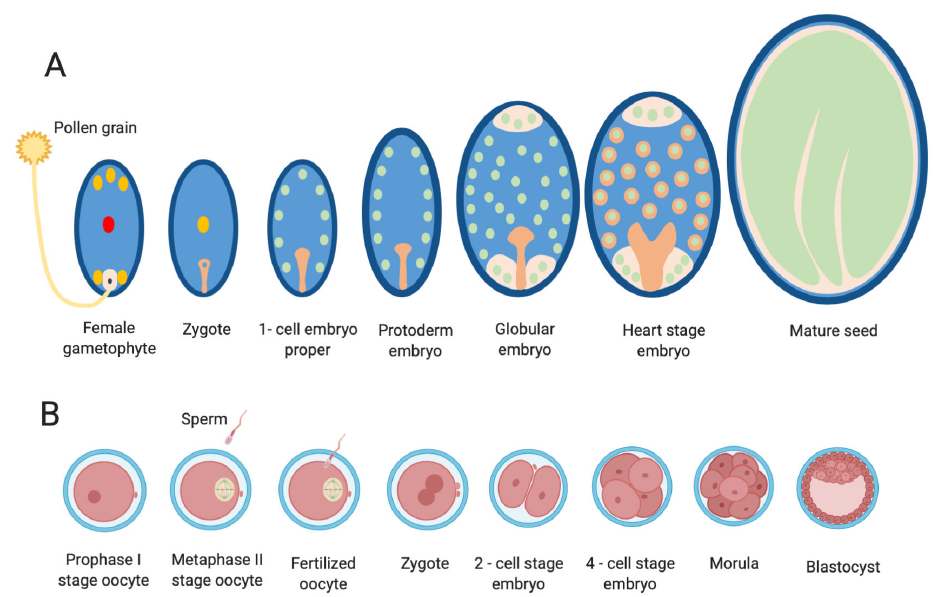
Figure 3. Schematic representation of fertilization and embryonic development in flowering plants ( A ) and mammals ( B ). Created with BioRender.com (https://biorender.com/, accessed on 28 January 2021). ( A ) In angiosperms, once the pollen grain attaches on the tip of the pistil, the pollen tube grows through the pistil and reaches the ovule located in the ovary. Upon fertilization, the ovule transforms into a seed. The ovule contains the female gametophyte, which consists of different specific cell types: 1 egg cell, 1 central cell, 2 synergid cells, and 3 antipodal cells. The two synergid cells attract the pollen tube in the direction of the ovule. When the pollen tube reaches the interior of the female gametophyte (embryo sac), the pollen tube delivers the two sperm cells inside the ovule. One of the sperm cells fuses with the egg cell, forming a diploid embryo, while the other sperm cell fuses with the nuclei of the central cell, forming a triploid endosperm. Once the zygote has been constituted, it undergoes a first asymmetric cell division. This mass of cells that constitute the embryo will be visible after several days of active division. The structures created in the process of double fertilization generate thus a diploid embryo and a triploid endosperm. The endosperm tissue surrounds and nourishes the embryo and it is typical in angiosperm seeds. In some species, it is completely absorbed at maturity (non-persistent endosperm) while, in others, like in most of the cereals, the endosperm is present until germination (persistent endosperm), and the cotyledons serve to absorb the stored nutrients delivered from the endosperm upon germination. At maturity, the maternal seed coat fully develops around the embryo and the endosperm. At the end of the process, a mature seed is formed containing a protected embryo that, after germination, can develop into a young plant. ( B ) In animals, the Prophase I arrested oocyte undergoes a process called oocyte maturation during which the oocyte completes meiosis I, extrudes the first polar body, and progresses to the metaphase stage of meiosis II. The fertilizing sperm penetrates the MII stage oocyte and forms the paternal pronucleus. The oocyte, in turn, completes meiosis II, extruding the second polar body and forming the maternal pronucleus. After DNA replication, the maternal and paternal genomes reconstitute the diploid status in a process called syngamy, the chromosome condense, and the first mitotic division of the zygote occurs. Thereafter, the blastomeres undergo consecutive mitotic divisions forming the blastocyst. In most mammals, oocyte maturation occurs in the ovarian follicle, while fertilization and early embryonic development occur in the oviduct. Afterwards, the embryo reaches the uterus where implantation